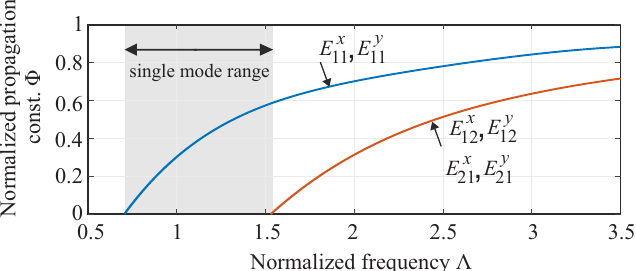
Figure 3. Plot of propagation constant versus normalized frequency for the first two, square DWG modes and implied mono-mode area.